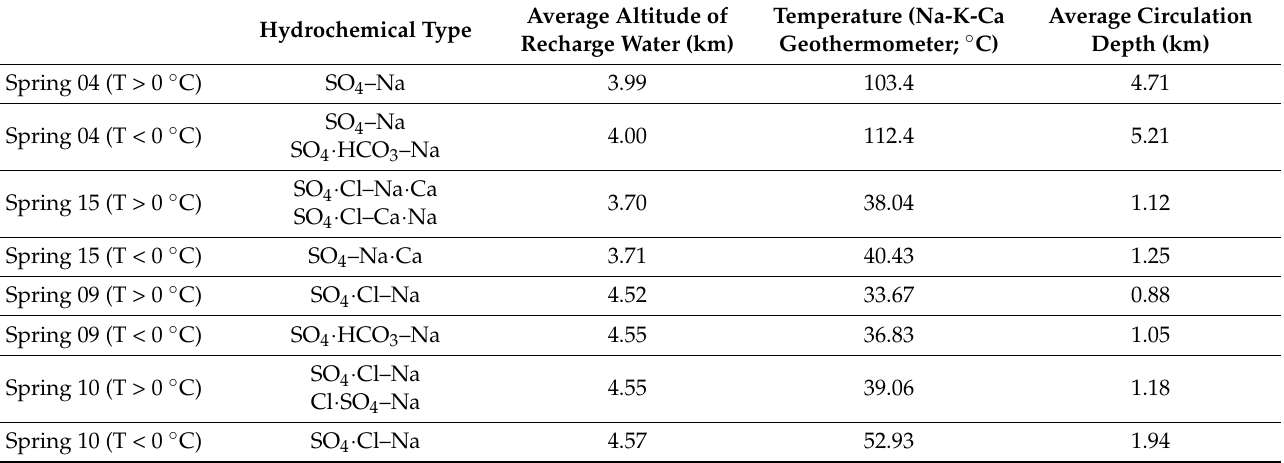
Figure 6. Hydrogeochemistry of spring water samples. ( a ) Piper diagram, with water types within the oval ranges from previous studies [35]. ( b ) Na–K–Mg ternary diagram and ( c ) Schoeller diagram showing the major ion characteristics of each spring. Table 1. Estimated aquifer